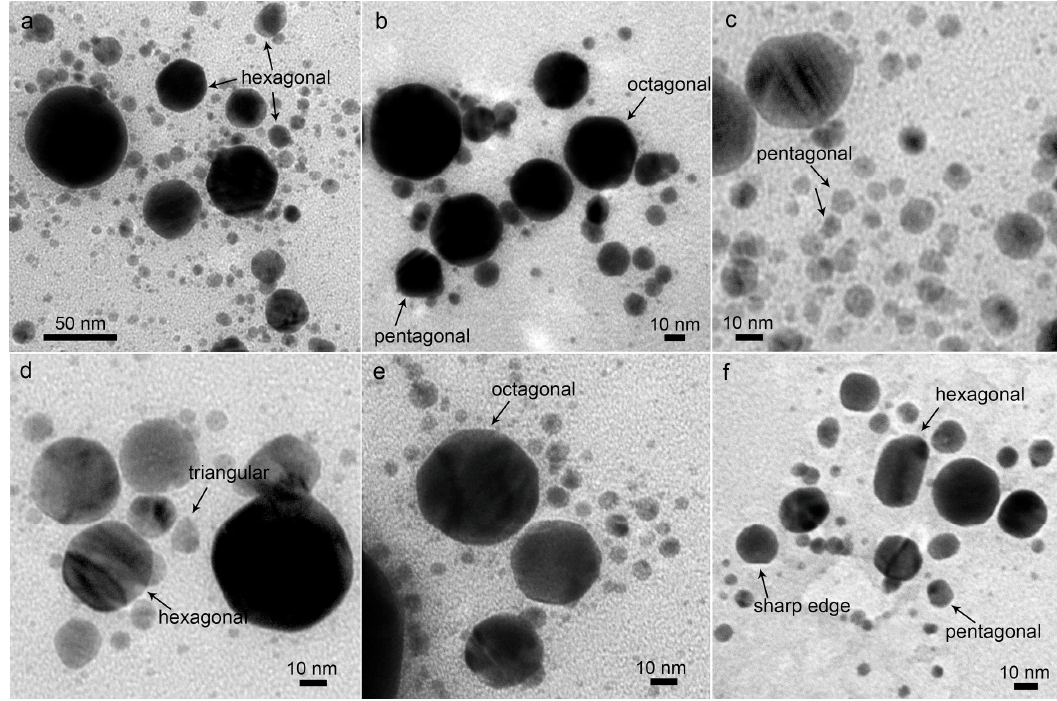
Figure 6. ( a – f ) Polygonal particles obtained after six months of storage of the colloids.